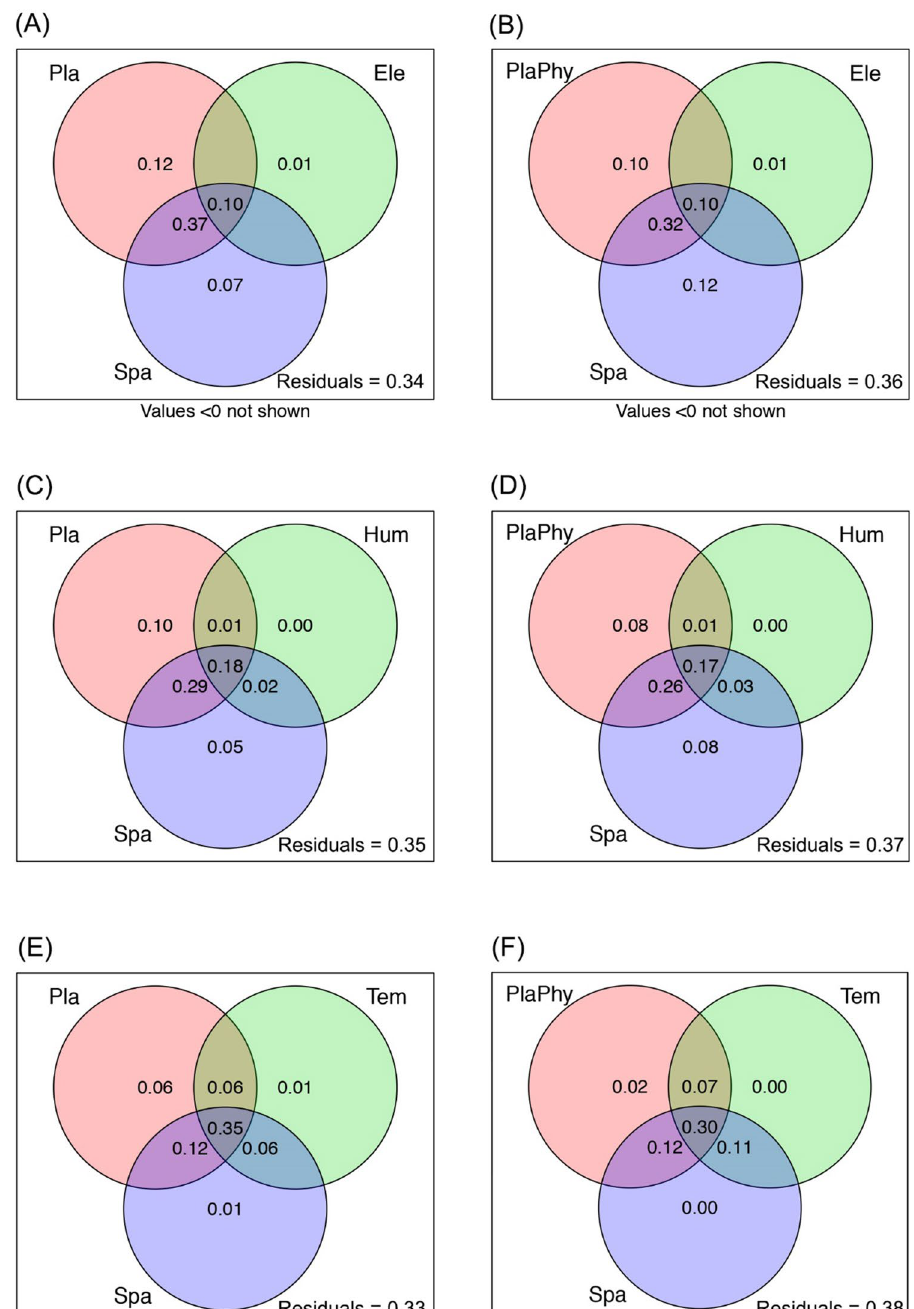
Figure 2. Variation partitioning results of redundancy analysis testing for the influence of plant community composition, plant phylogeny, environmental variation (elevation metrics, humidity metrics and temperature metrics) and spatial distance on wood-boring longhorn beetle composition in the Yunnan province, SW China. Pla plant species composition, PlaPhy plant phylogeny, Spa spatial distance, Ele elevation metrics, Hum humidity metrics, Tem temperature